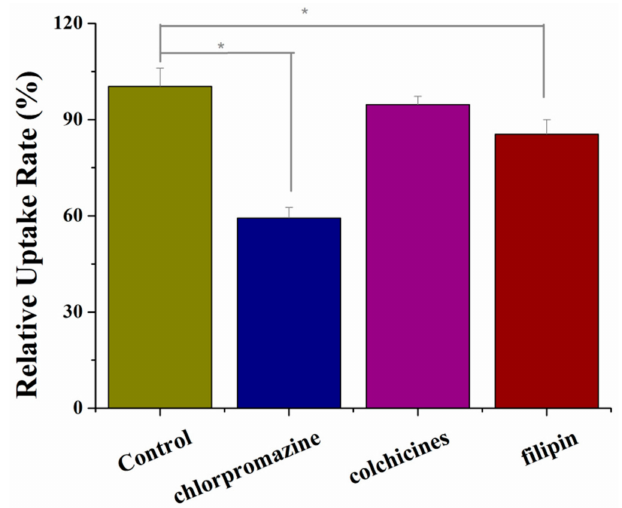
Figure 8. E ff ects of inhibitors on the internalization of Thz / PPM in MS ( n = 3). * p < 0.05.